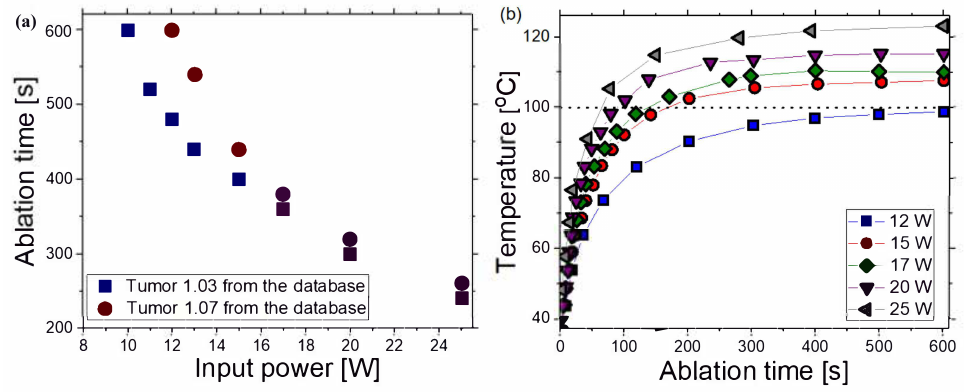
Figure 6. ( a ) Dependence of the ablation time on the input power for tumor 1.03 [51] (blue squares) and tumor 1.07 [51] (red circles). ( b ) Temperature as a function of the ablation time for various input power values calculated in the center of the heating